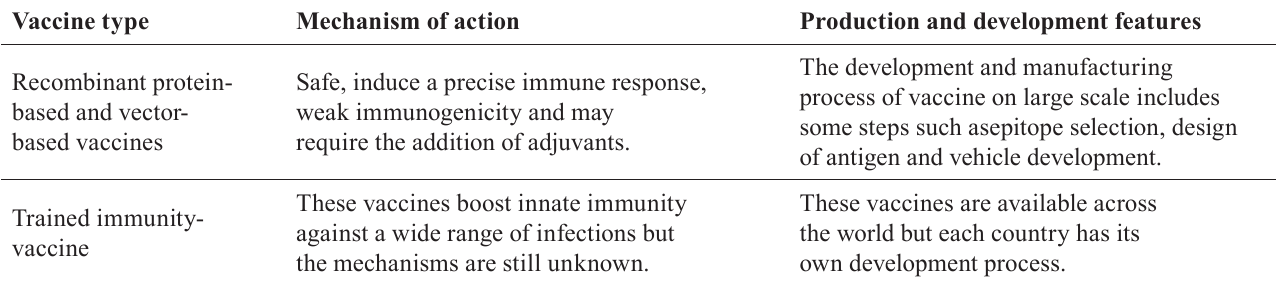
TABLE I - D ifferent types of vaccines, their mechanism of action and development